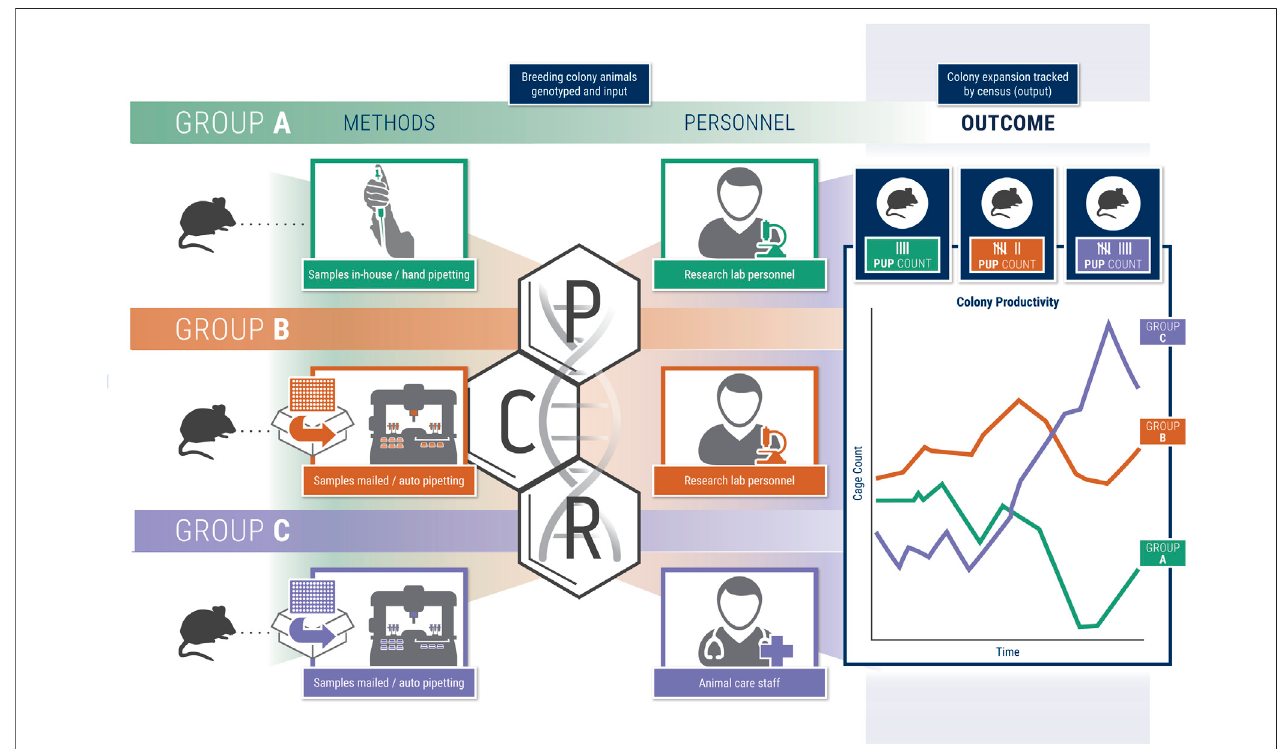
FIGURE 1 | Schematic fi gure representing the study groups A-C and overall study design.